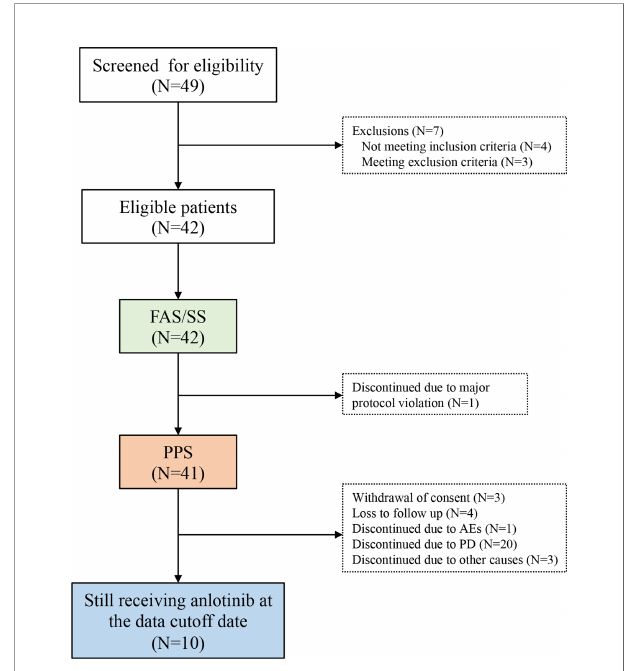
FIGURE 1 | The study fl owchart. AE, adverse event; FAS, full analysis set; ITT, intention-to-treat; PPS, per-protocol set; SS, safety